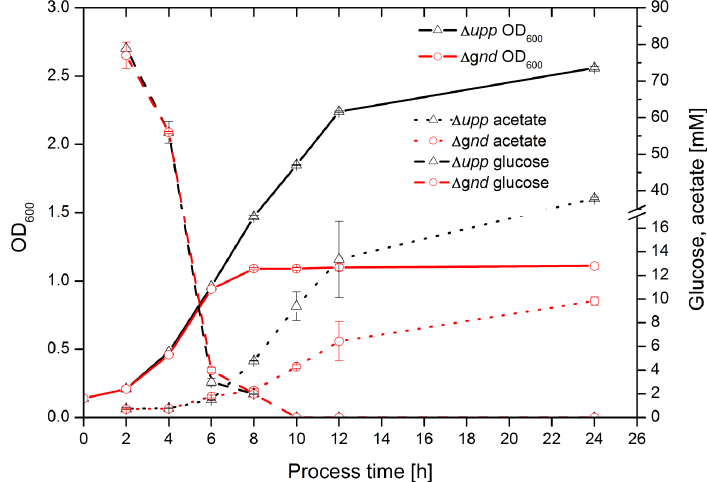
Figure 3. Growth (full lines) of Δ upp ( Δ , black) and Δ gnd (o, red) strains. Glucose (dashed lines) and acetate (dotted lines) concentration in supernatant at a sequentially sampled